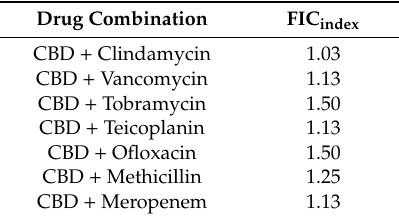
Table 2. Synergy test on methicillin-resistant Staphylococcus aureus (MRSA) USA300, two-fold dilution series of both antibiotics and CBD, 128–0.5 µ g / mL and 16–0.25 µ g / mL, respectively. FIC index ≤ 0.5 is considered synergy; FIC index between 0.5 and 1 is considered additive; FIC index between 1 and 4 is considered indi ff erent; and FIC index ≥ 4 is considered